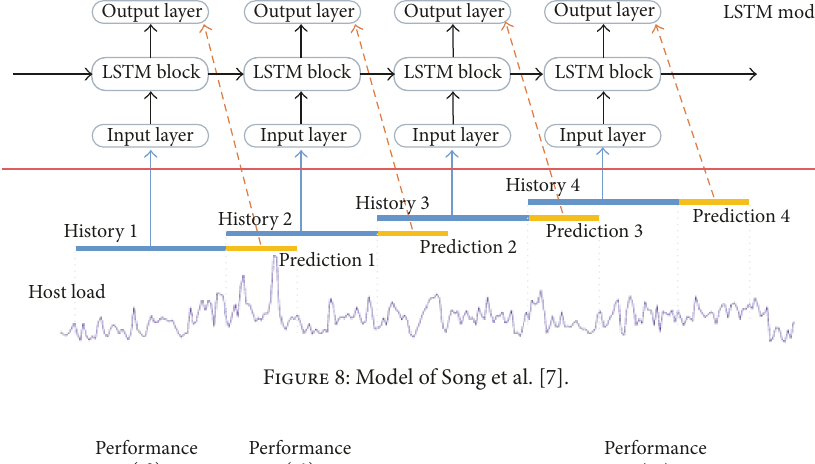
Figure 8: Model of Song et al. [7].